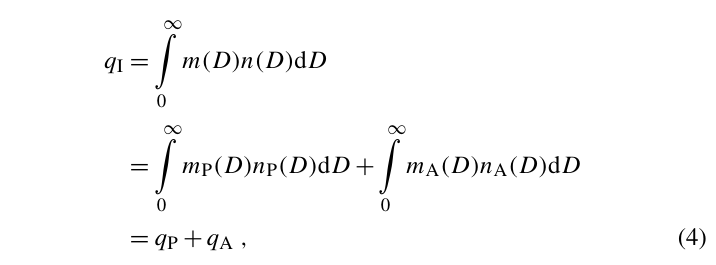
Table 1. Characteristics of the NXPol polarimetric radar. Further specifications and details can be found in Neely et al.